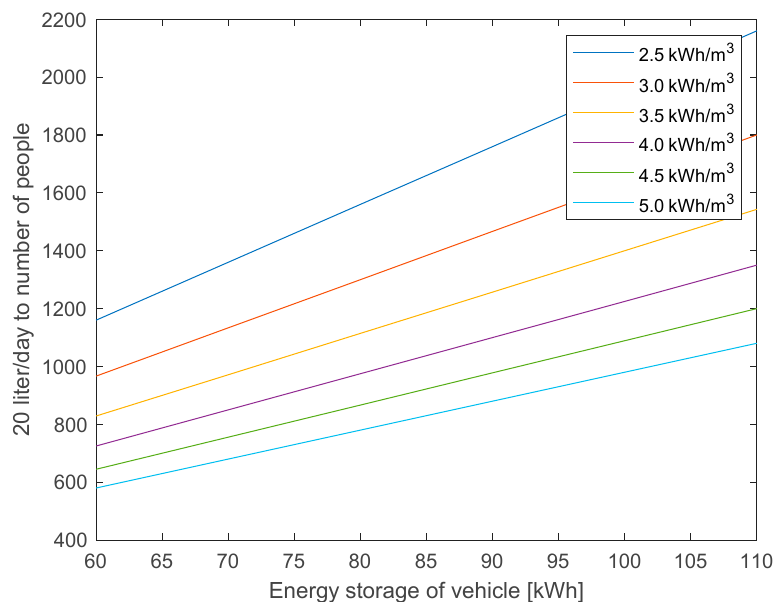
Figure 4. The energy storage of one EV affects the number of people that could benefit from an RO system installed in it, if 20 L freshwater per person each day is assumed, and this varies for different energy needs of the RO system (kWh/m 3 ).